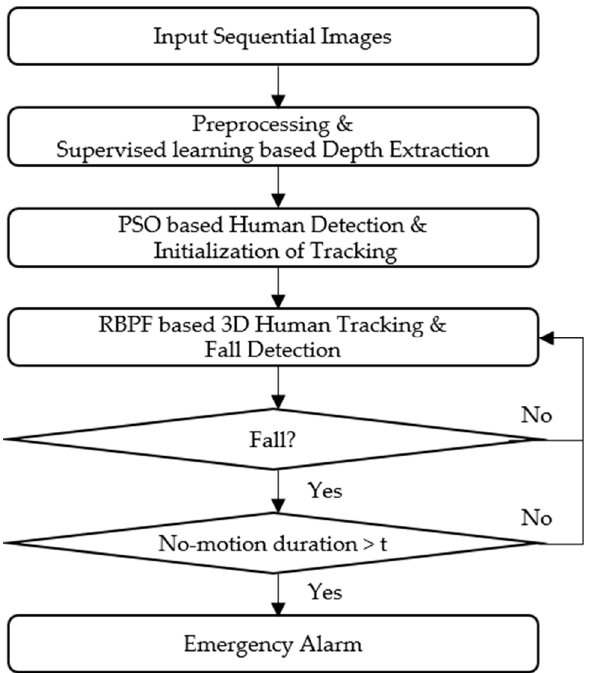
Figure 1. Proposed fall detection algorithm.